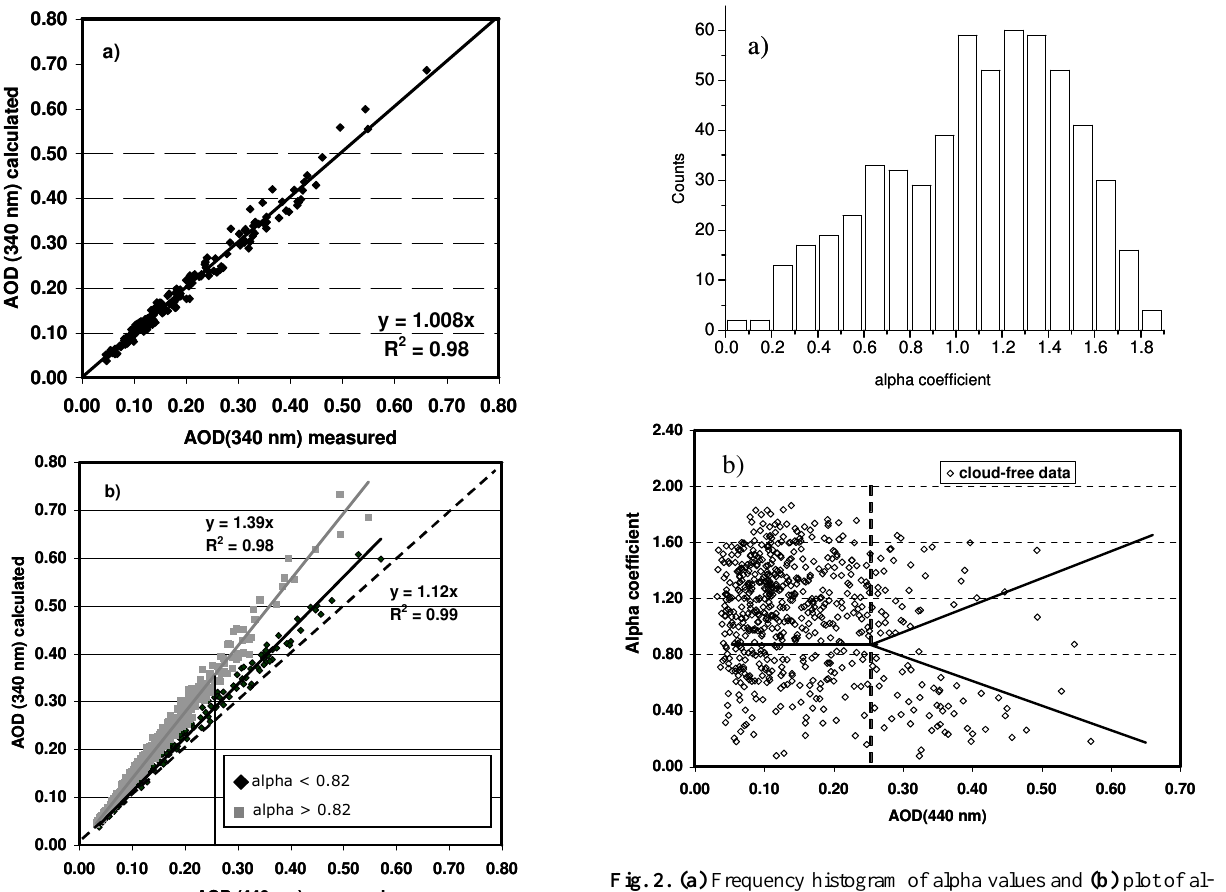
Fig. 2. (a) Frequency histogram of alpha values and (b) plot of al- pha versus AOD at 440nm during the analysed OMI period (2004– 2008) under cloud-free